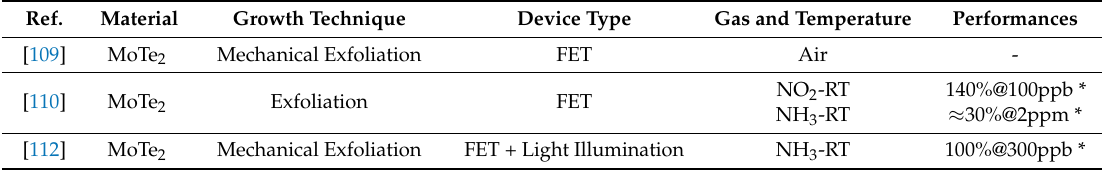
Table 4. Summary of MoTe 2 gas sensing devices, target chemical compounds and performances. RT stands for room temperature. * in N 2 atmosphere.